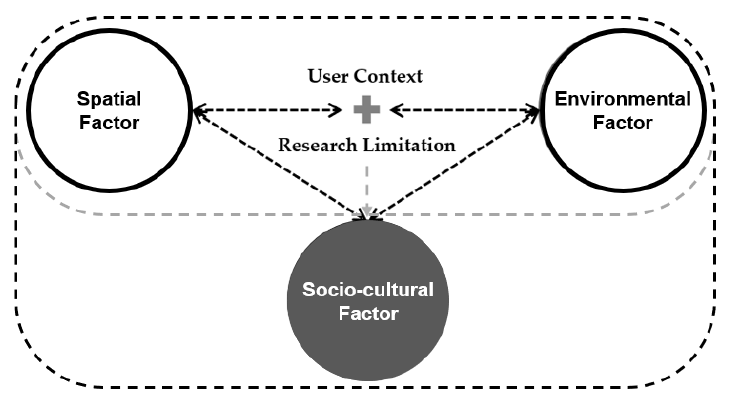
Figure 4. Research limitation (illustration: author).